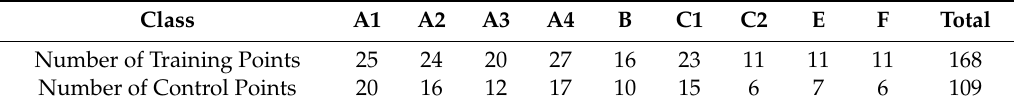
Table 5. Training and control points.